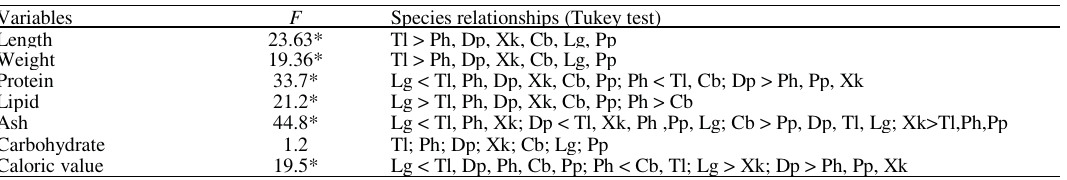
Table 3. Analysis of variance considering preys’ size (length and weight), proximate-composition (% dry mass) and caloric value (kcal g -1 dry mass) of the prey species of Trichiurus lepturus in northern Rio de Janeiro State, Brazil. Cb: Chirocentrodon bleekerianus ; Dp: Doryteuthis plei ; Lg: Lycengraulis grossidens ; Ph: Pellona harroweri ; Pp: Peprilus paru ; Tl: Trichiurus lepturus , and Xk: Xiphopenaeus kroyeri . * P < 0.05.